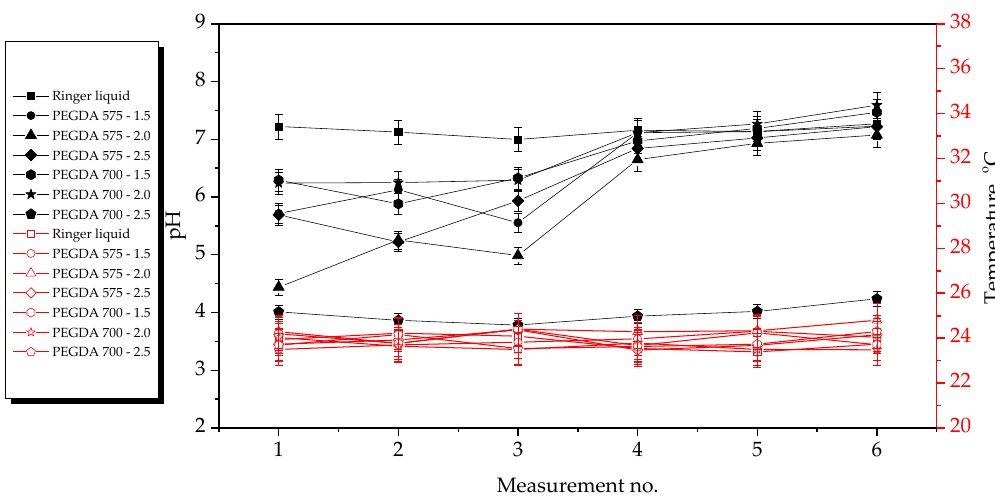
Figure 5. Results of hydrogel incubation in Ringer solution. Measurement no.